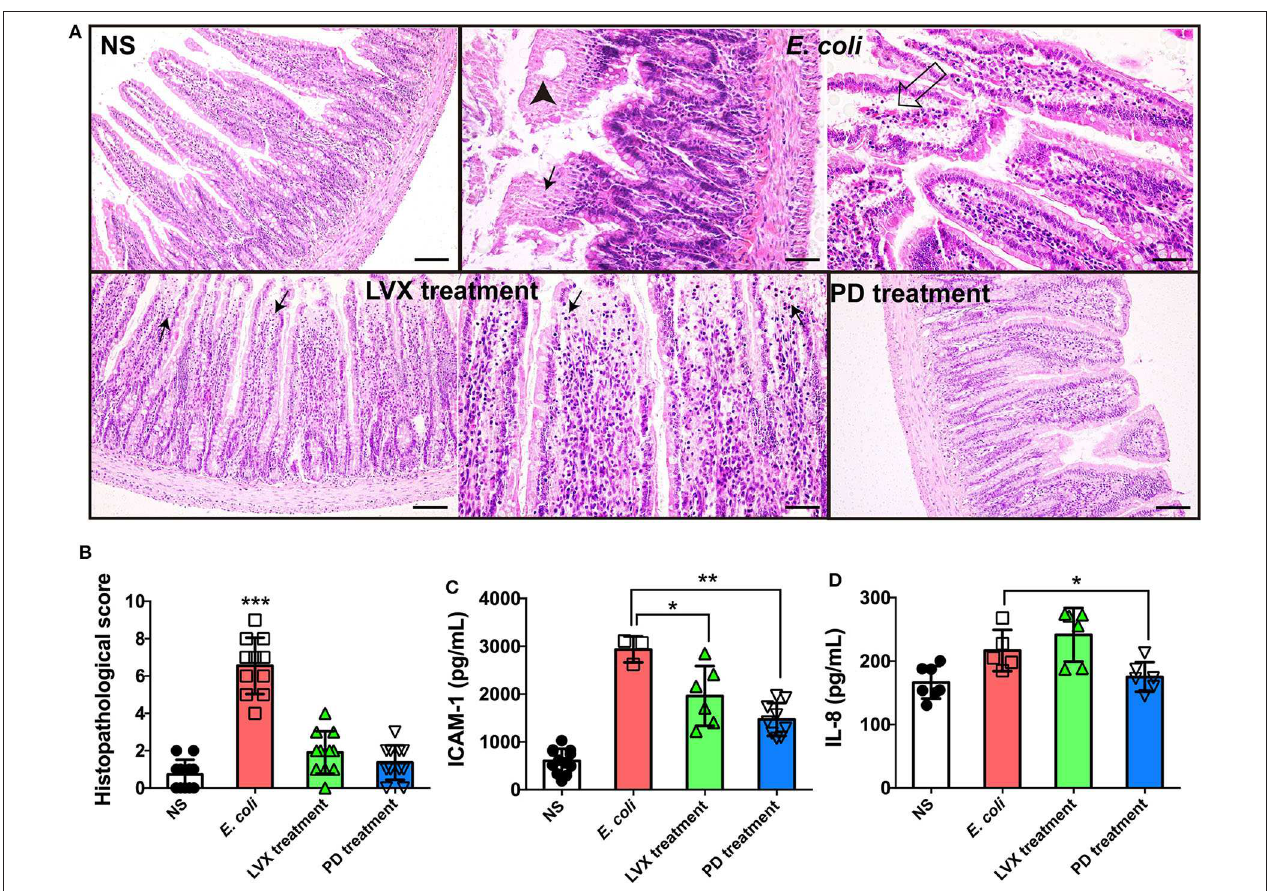
FIGURE 2 | PD treatment triggered less intestinal injury comparing to LVX treatment. (A) HE staining of intestine under PD or LVX treatment of E. coli infection. Rats were infected with E. coli O 101 (1 × 10 11 cfu/kg) for 3 days. Rats treated with normal saline (NS) as an uninfected group. Then the infected rats were received oral administration of PD or LVX. Arrowhead showed coagulation necrosis, while empty arrow showed mucosa lamina propria with congestion. Black arrows pointed to focal necrosis with inflammatory cell infiltration. Scar bar = 100 µ m. (B) The pathological scores of the intestine presented the severity of intestine pathological lesions. (C,D) LVX treatment increased IL-8 and ICAM-1 release. Values represented the mean ± SD (* P < 0.05, ** P < 0.01, *** P < 0.001, n =